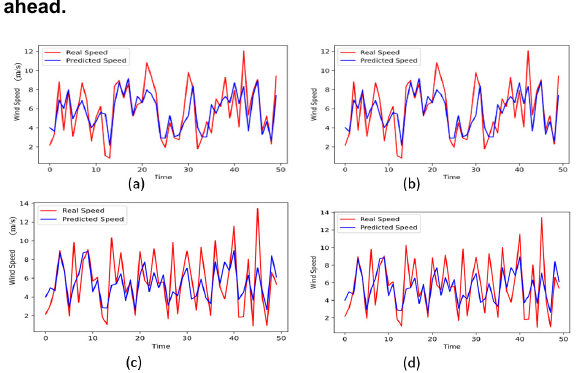
Figure 16. Wind speed prediction in Case 4, (a) 1 hour ahead (b) 2 hours ahead, (c) 5 hours ahead, (d) 7 hours ahead.